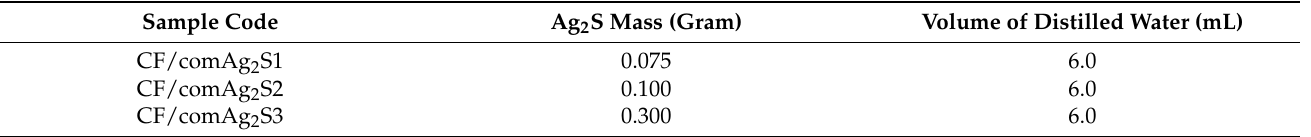
Table 2. Sample code and composition of refracted commercial Ag 2 S.